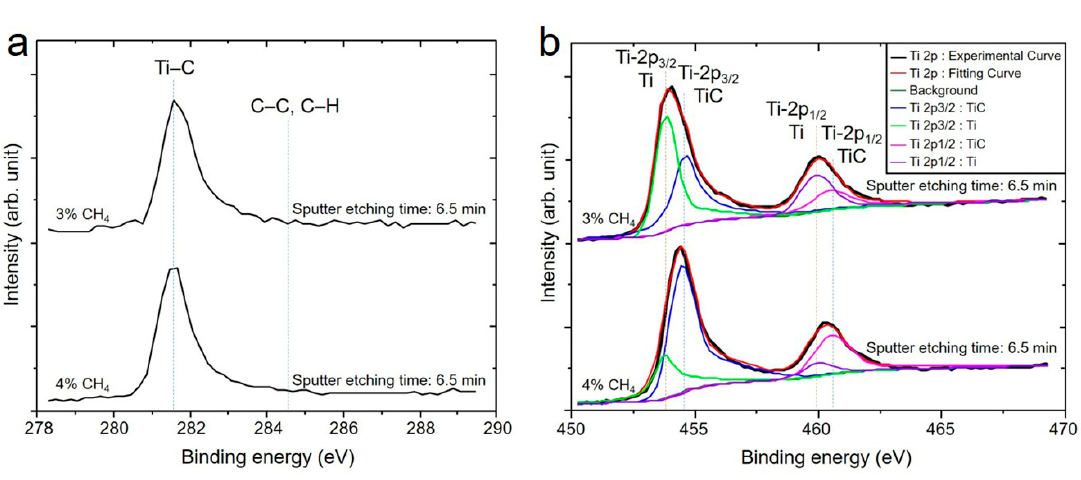
Figure 6. X-ray photoelectron spectroscopy (XPS) spectra for ( a ) C-1s and ( b ) Ti-2p after sputter etching for 6.5 min. The intensity has been normalized.